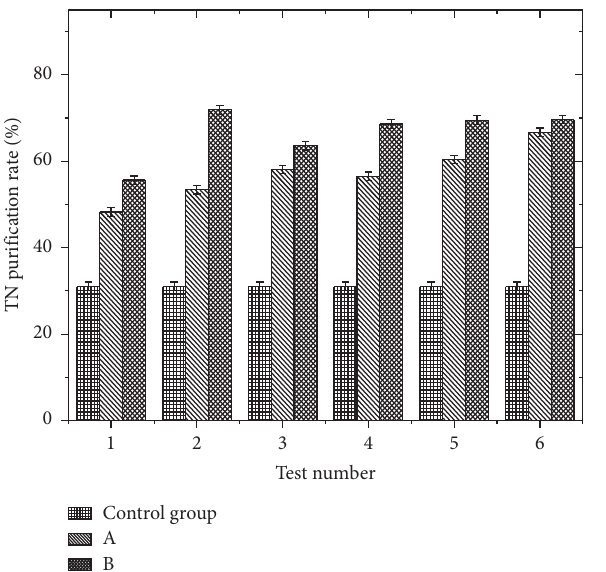
Figure 7: TN purification effect of permeable concrete. Note: A- 1 ∼ A-6: permeable concrete specimens with unmodified diatomite and zeolite powder in different dosages; B-1 ∼ B-6: permeable concrete specimen with modified diatomite and zeolite powder in different dosages.